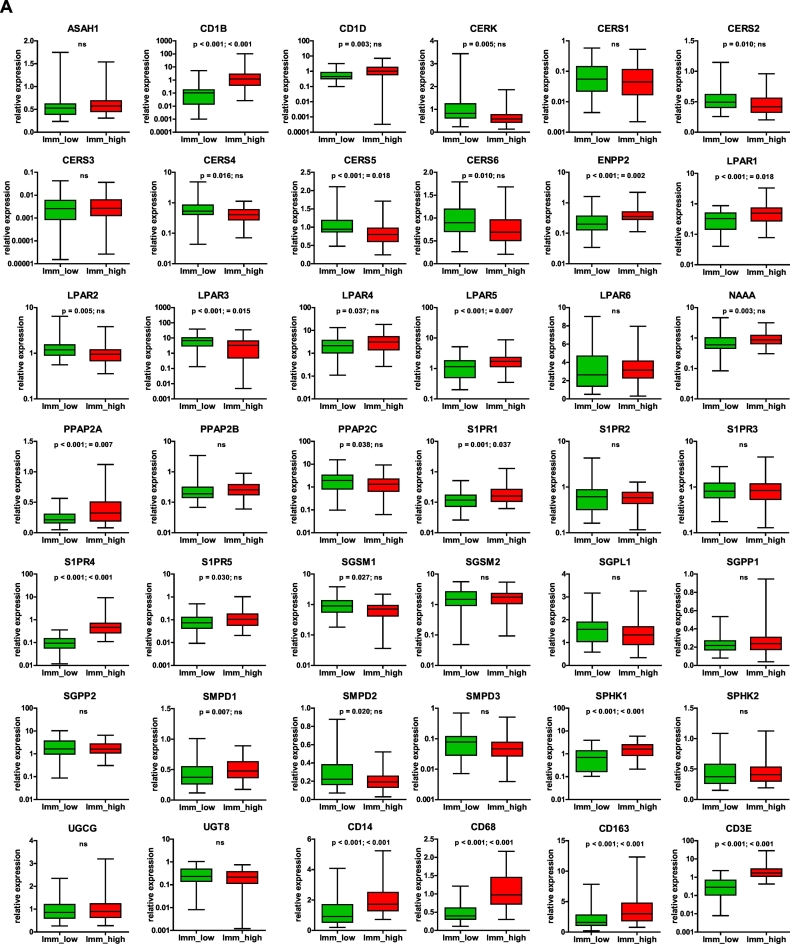
Comparative analysis of gene expression data sets in immune low versus immune high subgroups and the link to chemotherapy response.A Boxplots of mRNA expression levels for immune low (n = 47) and immune high (n = 56) subgroups are shown for all genes composing the sphingolipid/lysophosphatidate/immune-associated signature. The boxplot represents the distribution of values; the line across the box represents the median; the box stretches from the lower hinge (the 25th percentile) to the upper hinge (the 75th percentile). The p-values and the Bonferroni-Holm corrected p-values of two-sided t-test are indicated; ns, not significant.B Table summarizing the results of group comparison in (A). Only genes showing significant difference are included; considering this study as exploratory the non-corrected p-values were used. Red color indicates a higher level of expression within a patient subgroup.C Comparative assessment of contribution of responders and non-responders to the total quantity for the patient subgroups designated as immune low (n = 47) and immune high (n = 56); p-value of two-sided Chi-squared test is shown. (For interpretation of the references to color in this figure legend, the reader is referred to the web version of this article.)